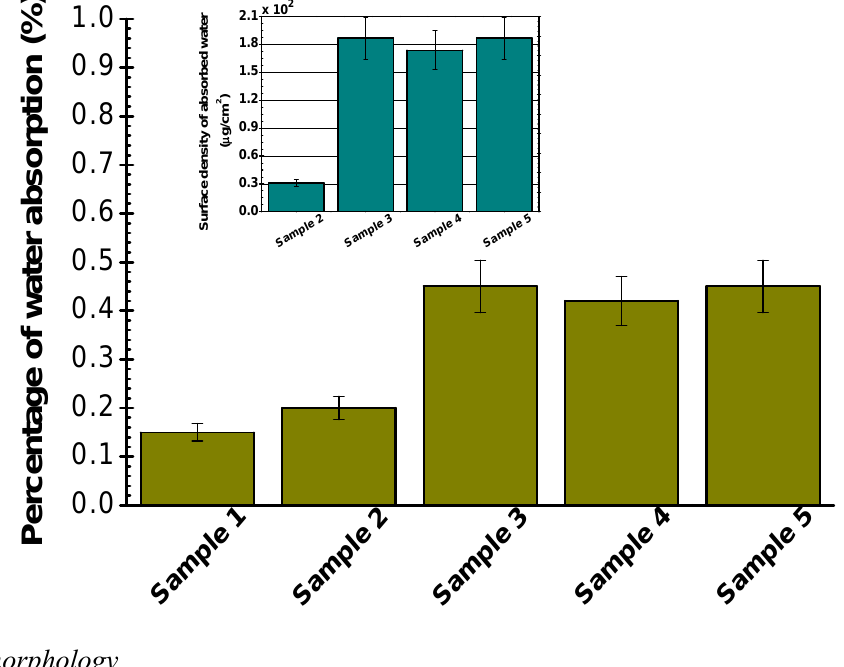
Figure 1. Percentage of water absorption after 24 h for Samples 1-5. The inset shows the corresponding surface density of absorbed water (error bars depict standard